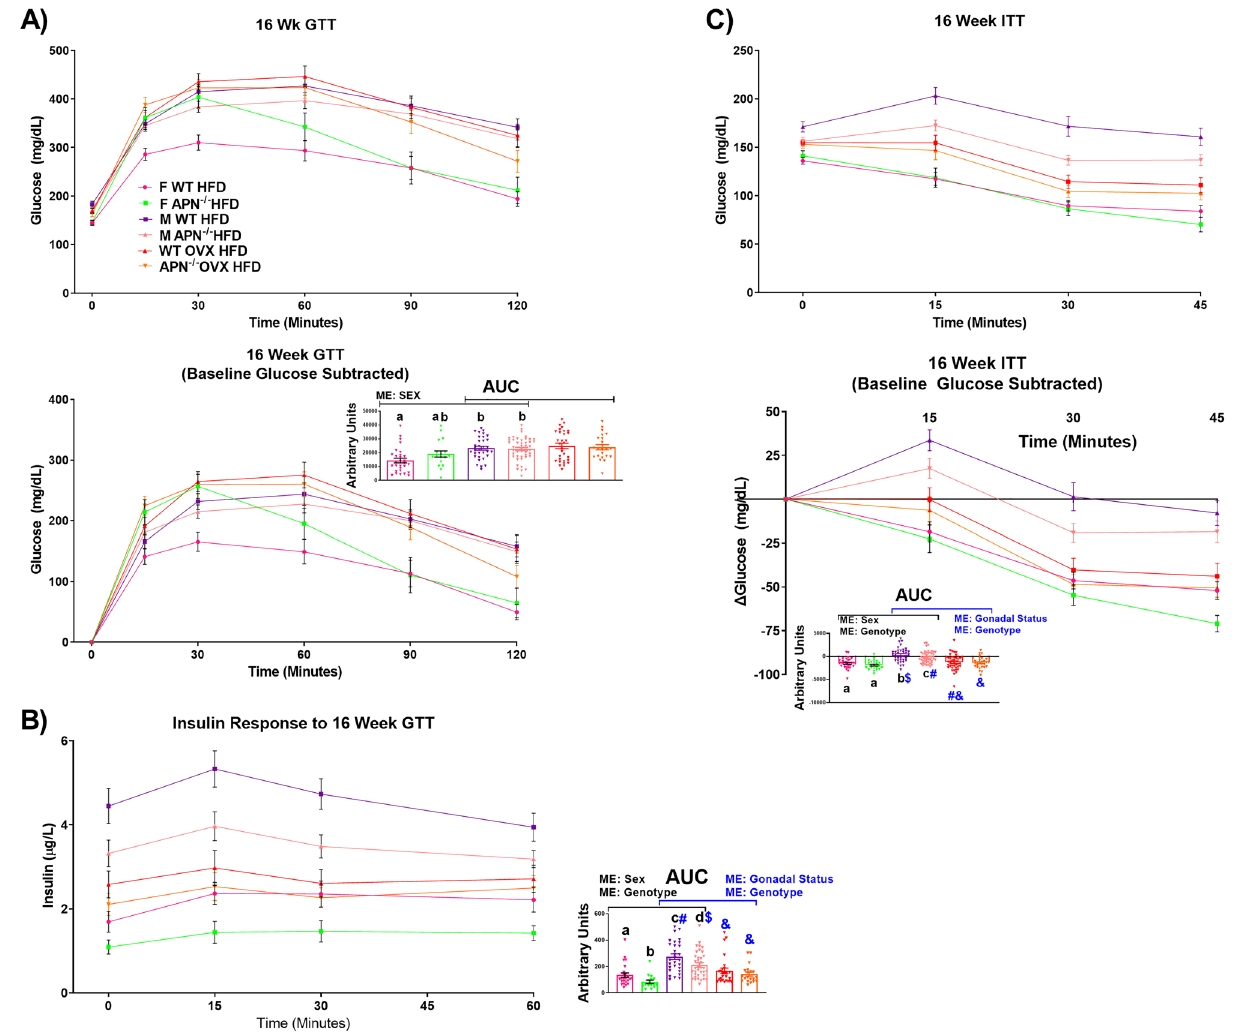
Figure 5. Adiponectin deficiency enhances insulin sensitivity in males and females, but has no beneficial metabolic effects in ovariectomized females. After 16 weeks of HFD, mice (n = 19–46) were assessed metabolically by examining a ( A ) GTT, ( B ) insulin response to the GTT, and ( C ) ITT. Data is presented as mean ± SE. Bar graphs not sharing a common letter or symbol are significantly different from one another (P < 0.05). ME = Main